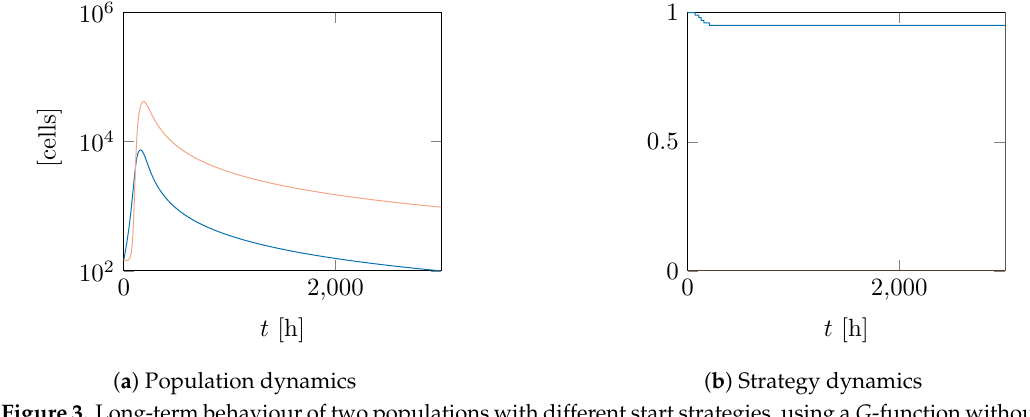
Figure 3. Long-term behaviour of two populations with different start strategies, using a G -function without additions. Both populations numbers are slowly converging in time course towards zero, with producers (dark line) having the lower